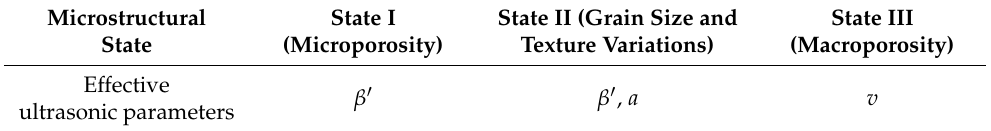
State III (Macroporosity)